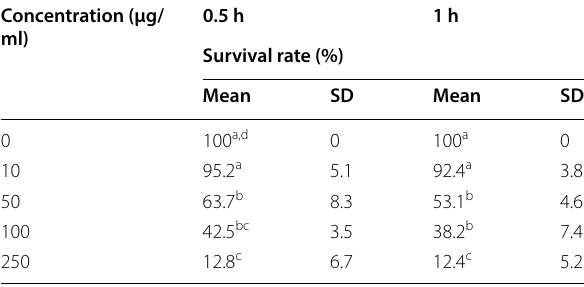
Table 1 Percentage survival rate of B. hyodysenteriae in response to B. subtilis -derived surfactin